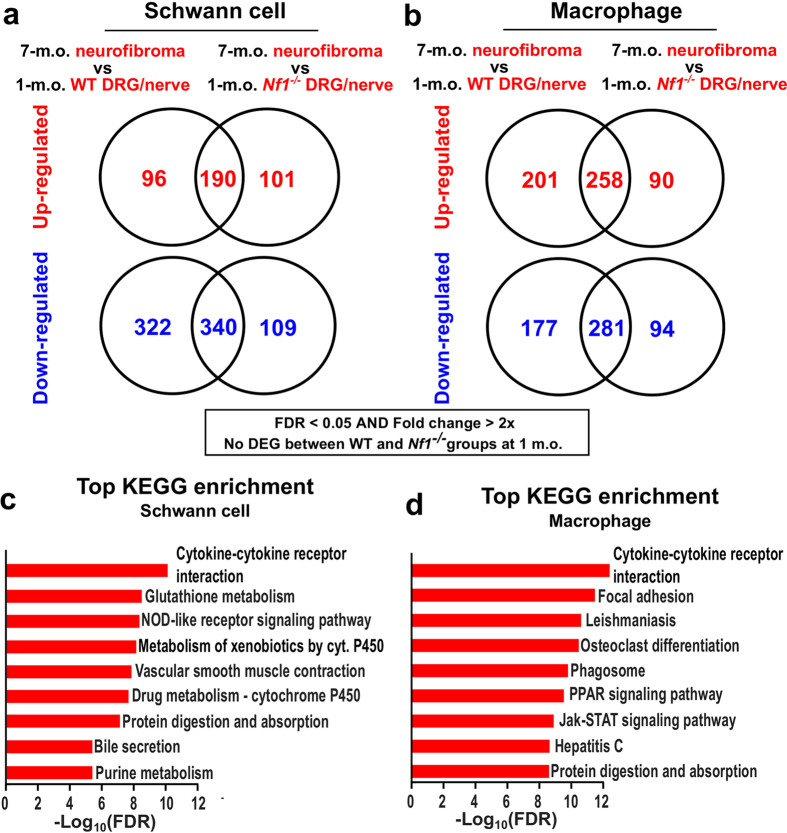
DEGs and gene set enrichment analysis.DEGs were predicted in (a) 7-to-1 month SC comparison and (b) 7-to-1-month-old macrophage comparison, using the limma method (fold change >2x and FDR q < 0.05). KEGG pathway analyses were performed using WegGestalt webserver using DEGs from (c) 7(Nf1−/−)-to-1(Nf1−/−) month SC comparison and (d) 7(Nf1+/+)-to-1(Nf1+/+) month neurofibroma macrophages. The designation Nf1−/− represents SCs from Nf1fl/fl;DhhCre mice; a mixture of wild-type and Nf1−/− SCs.